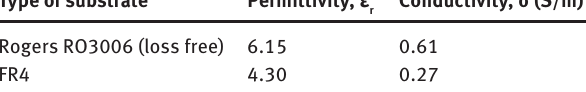
Table 1 Dielectric properties of substrates for helical antenna.